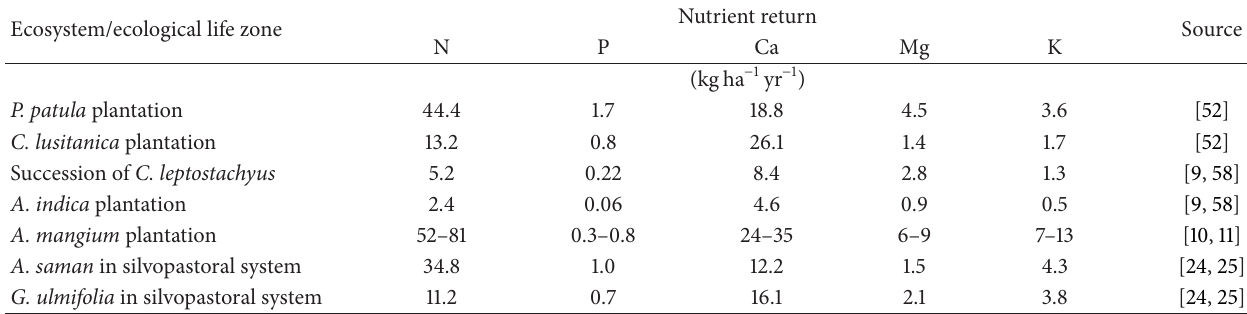
Table 4: Potential return of nutrients via leaf litterfall from the dominant plant species in different ecosystems obtained from restoration projects conducted in Colombia.